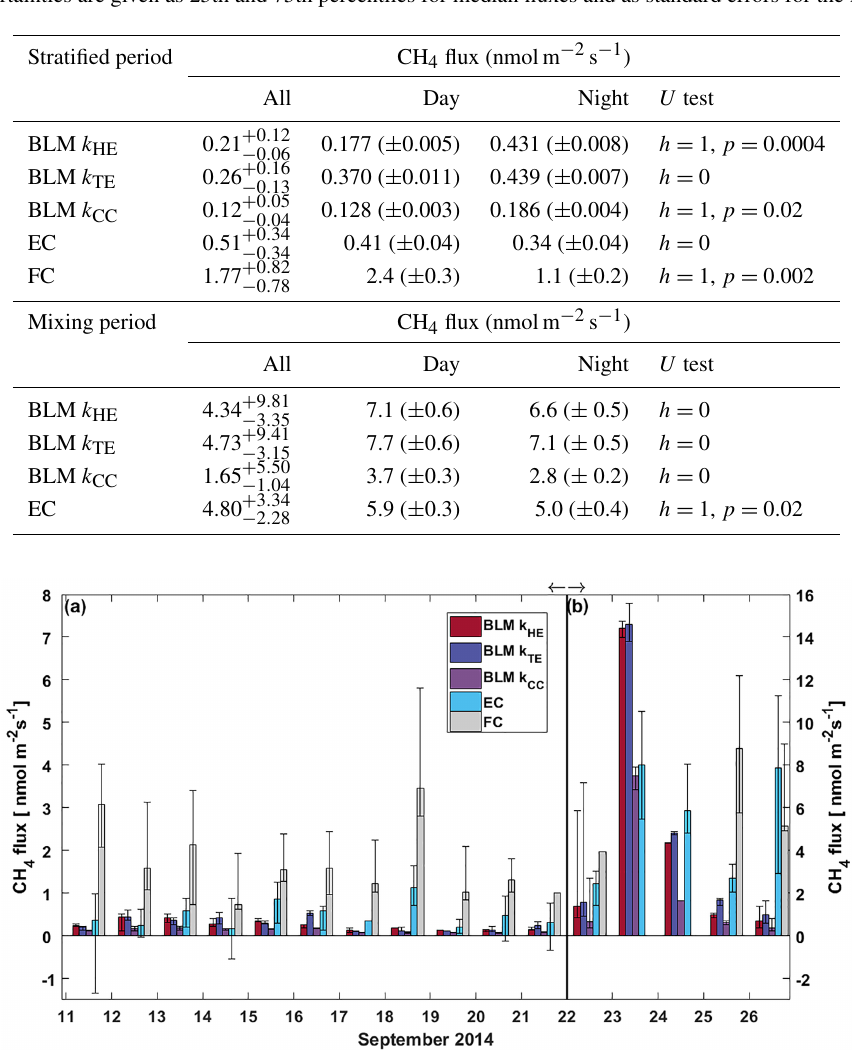
Table 1. Median of all CH 4 fluxes and average daytime and night-time CH 4 fluxes during lake stratification and mixing periods using different measurement methods. Results of Mann–Whitney U test comparing differences between daytime and night-time fluxes are given in U test column. Note that FC fluxes are averaged also over different measurement spots. Mixing period did not include enough FC measurements for this analysis. Uncertainties are given as 25th and 75th percentiles for median fluxes and as standard errors for the flux averages.